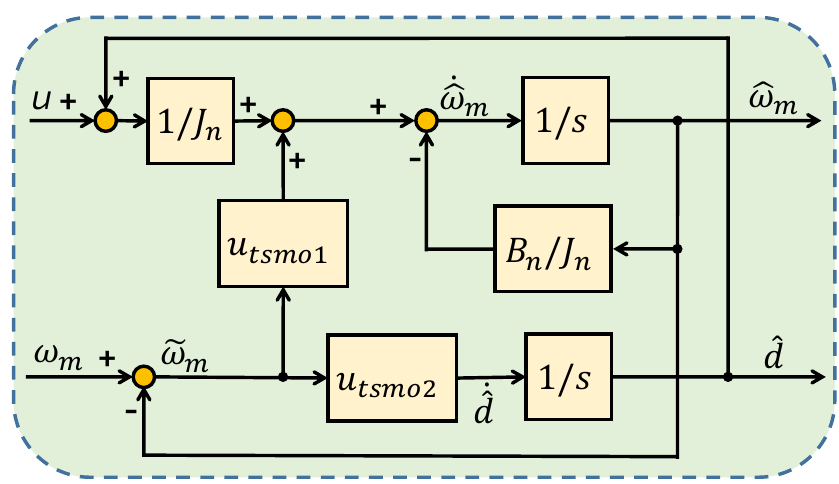
Figure 2. Block diagram of a high-order terminal sliding-mode